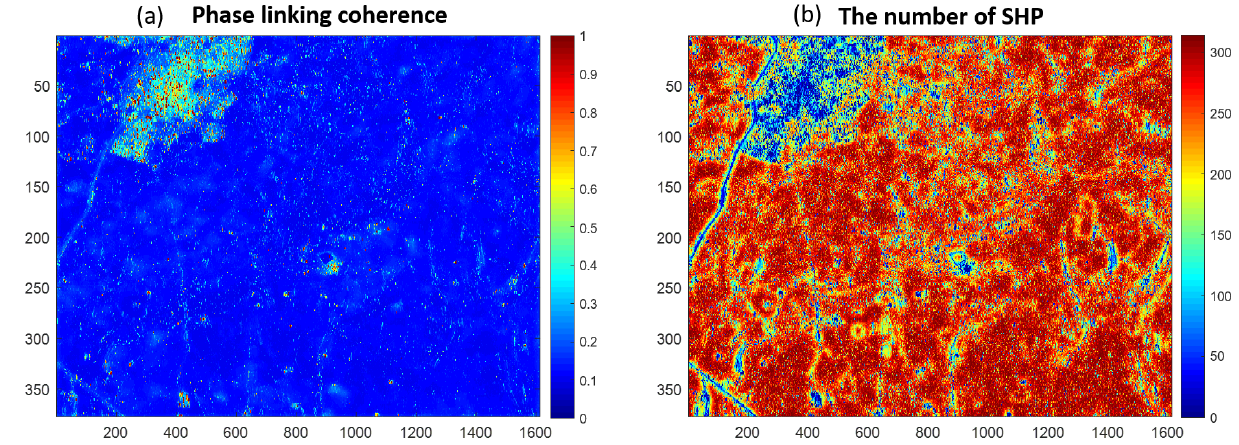
Figure 4. Internal results from PSDS-based processing. ( a ) the phase linking coherence corresponding to the SHP map; ( b ) the number of SHP identified using a 9 × 35